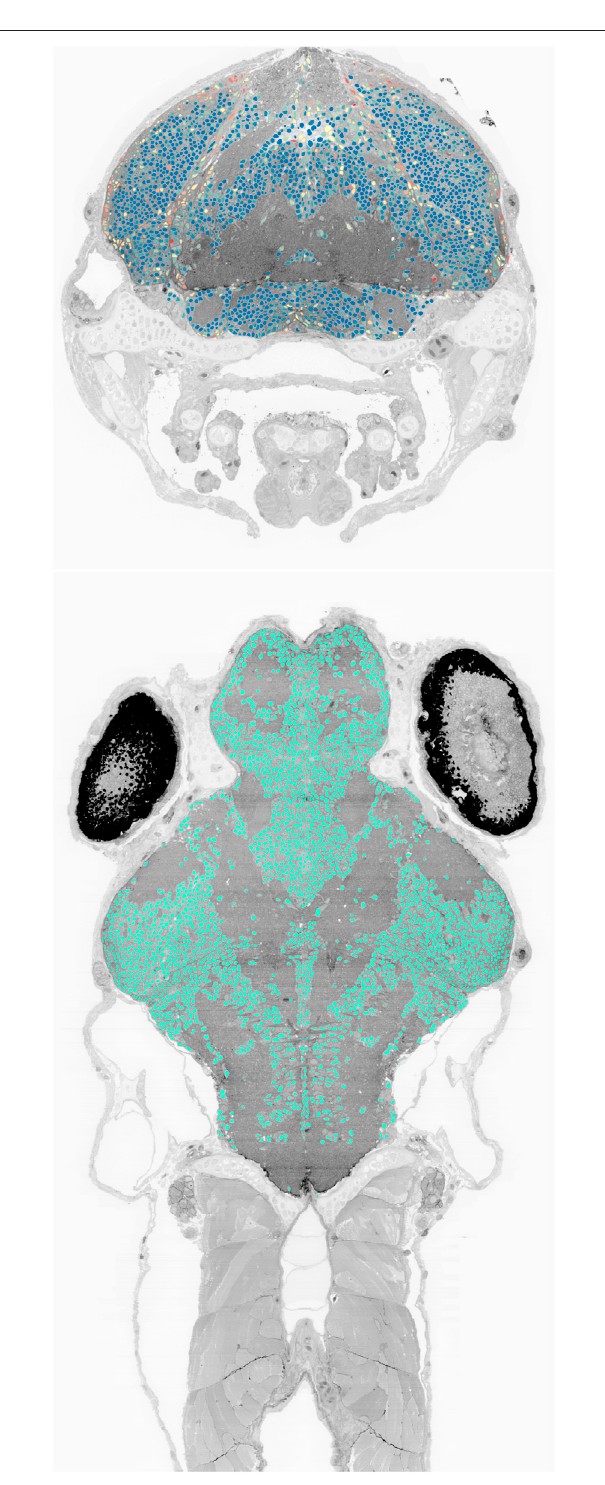
FIGURE 9 | Cell nucleus segmentation results overlaid onto zebra fi sh EM volume cross-sections through the transverse ( top , blue to red color map varies with cell sphericity) and horizontal (bottom)